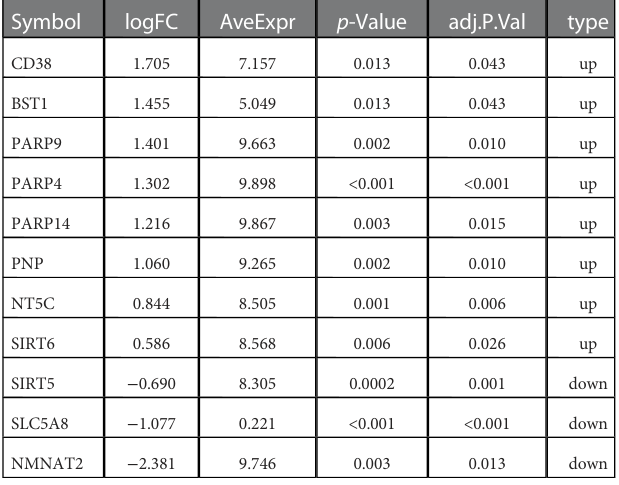
TABLE 1 Differentially expressed genes between glioma and normal